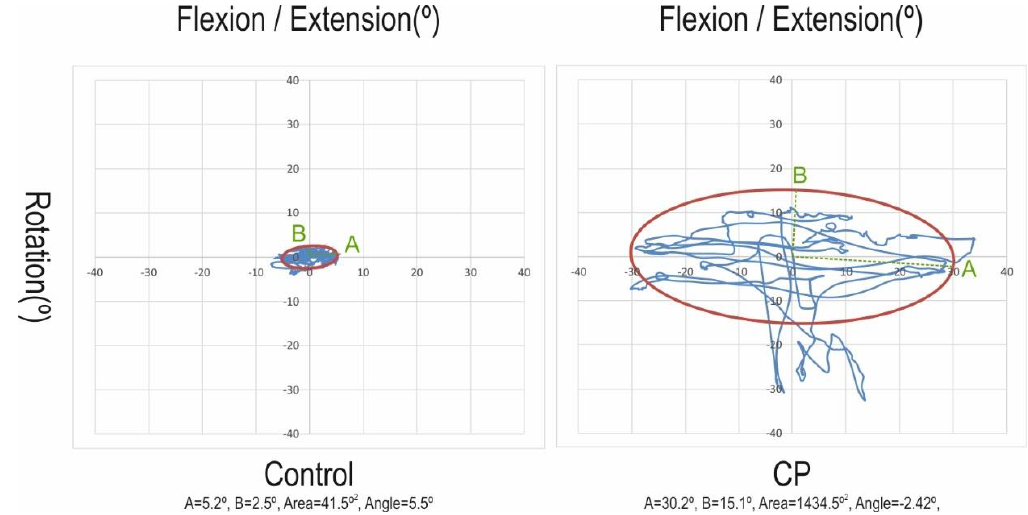
Figure 2. Ellipse encompassing 95% of the flexion / extension and rotation displacements for control and cerebral palsy (CP) individuals.